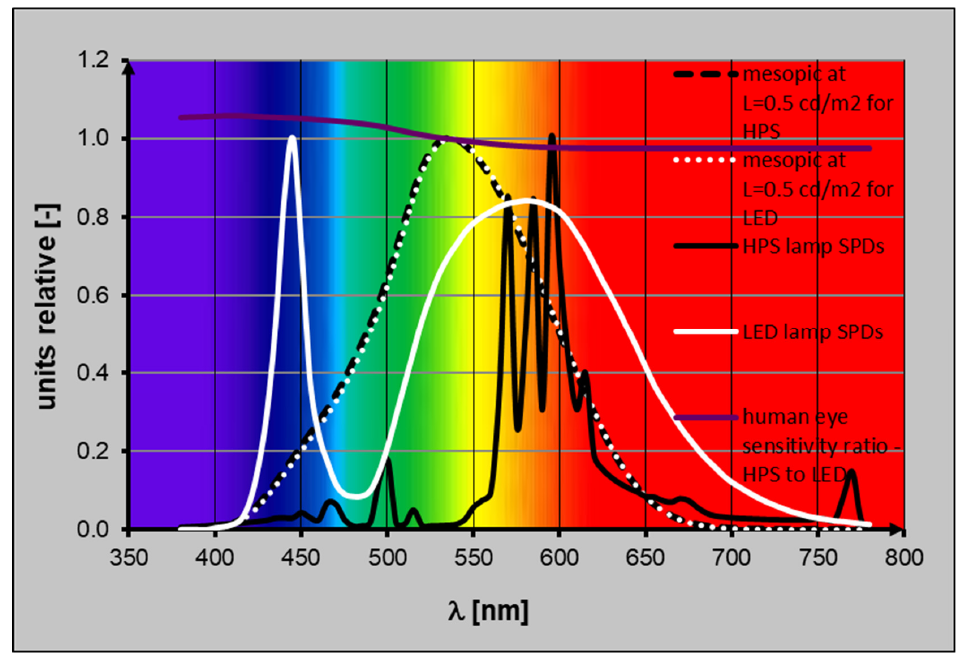
Figure 2. Spectral distribution of HPS and LED lamps and the spectral efficiency of the human eye at luminance L e = 0.5 cd/m 2 obtained with these lamps and for luminance L e = 0.5 cd/m 2 , the quotient of the spectral sensitivity of the eye at HPS lighting (CCT 2060 K) to the sensitivity of the eye at LED lighting (CCT 4000 K).